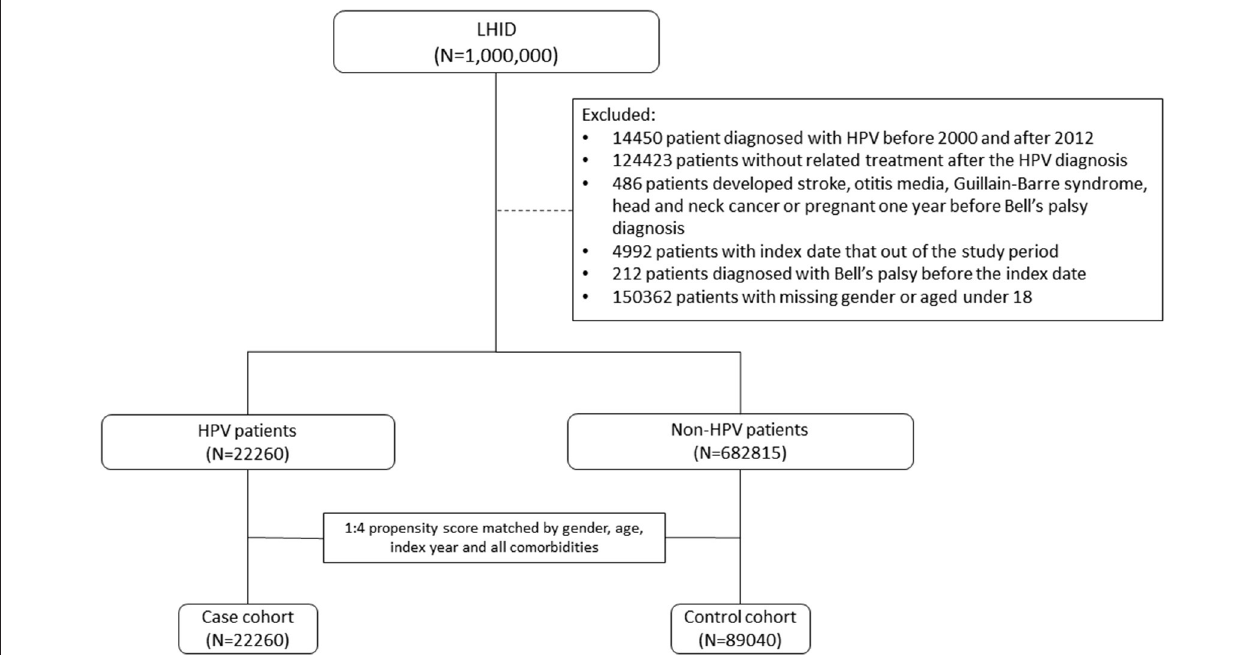
FIGURE 1 | Flow chart of the cohort assembly in the current